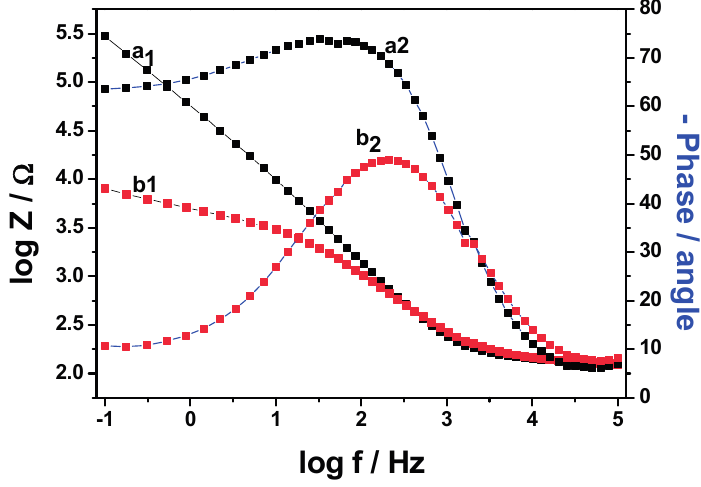
Figure 7. Frequency dependences of the impedance (a 1 and b 1 ) and phase shift (a 2 and b 2 ) in the Bode plots of GCE (a 1 and a 2 ) and GCE/PT-PDMA-MWCNT (b 1 and b 2 ) in PBS at 0